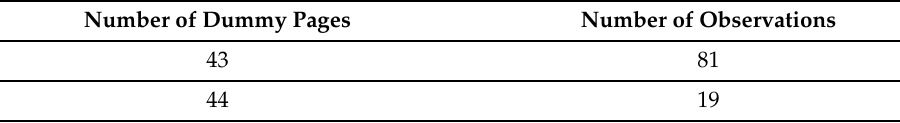
Table 2. Dummy page-count measurements for q